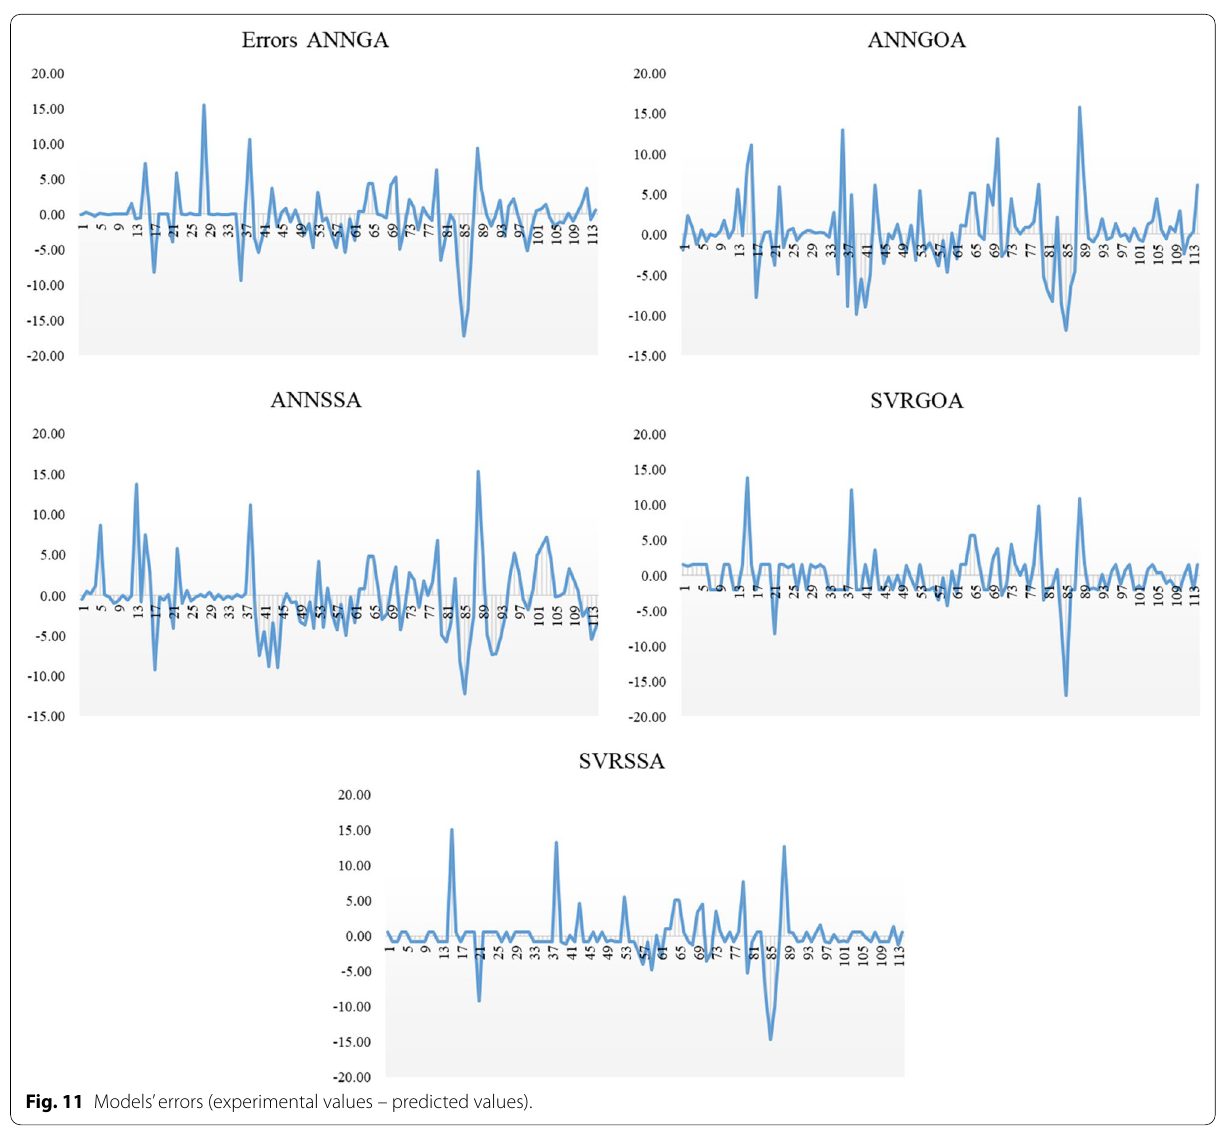
Fig. 11 Models’ errors (experimental values – predicted